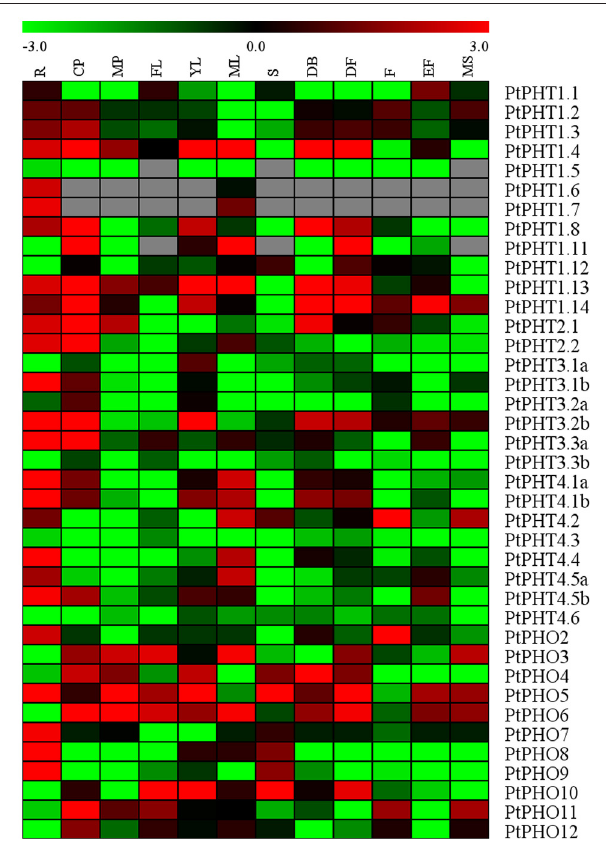
FIGURE 4 | The expression profiles of PHT genes in different tissues of Populus tremula . Heatmap shows PHT gene expression across 12 various tissues including roots (R), dormant cambium-phloem (CP), mature petiole (MP), freshly expanded leaves (FL), expanding young leaves (YL), mature leaves (ML), suckers (S), dormant buds (DB), dormant flowers (DF), expanded flowers (F), expanding flowers (EF), and mature seeds (MS). The data were obtained from PopGenIE (http://popgenie.org/) ( Sjodin et al.,